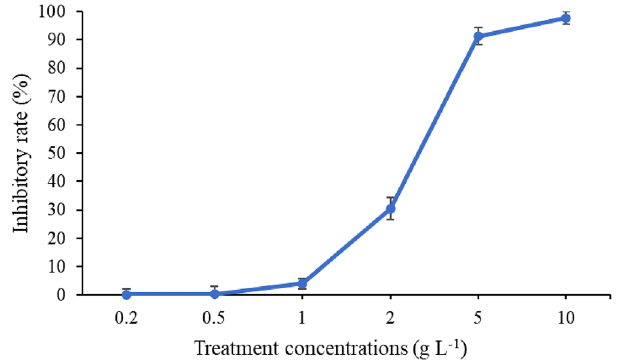
Figure 2. Moso bamboo leaf extract inhibits the growth of the phytopathogen P. capsici .